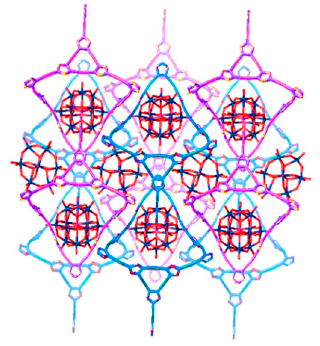
Figure 1. The metal-organic polycatenation structure of catalyst 1 .